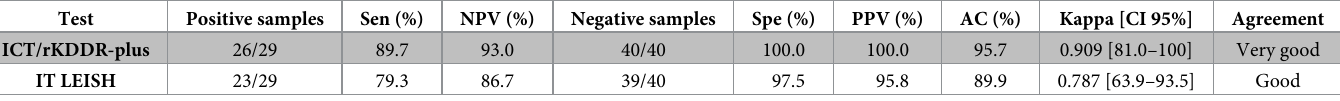
Table 3. Diagnostic performance of immunochromatographic tests with human sera from patients infected with Leishmania infantum , Trypanosoma cruzi and healthy controls.